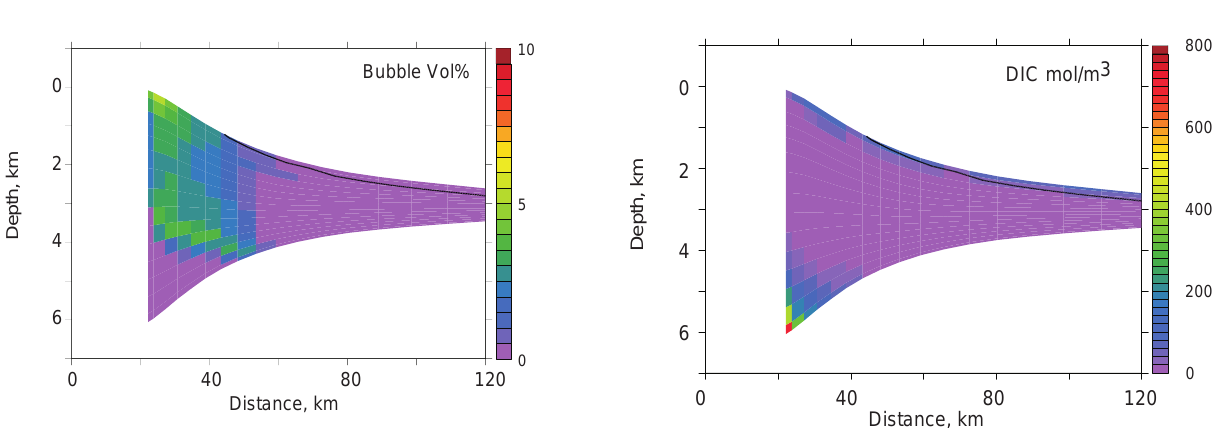
Fig. 9. Dissolved methane concentration relative to equilibrium with respect to gas (below the stability horizon, solid black line) or hydrate (above the stability horizon), for the Base scenario, with additional scenarios in the Supplement file CH 4 .pdf. An anima- tion can be seen at http://geosci.uchicago.edu/ ∼ archer/spongebob active/ch4.active.movie.gif.